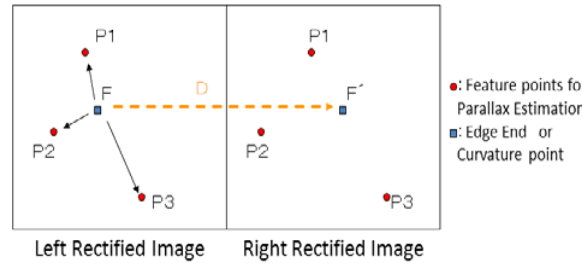
Figure 4. Parallax estimation